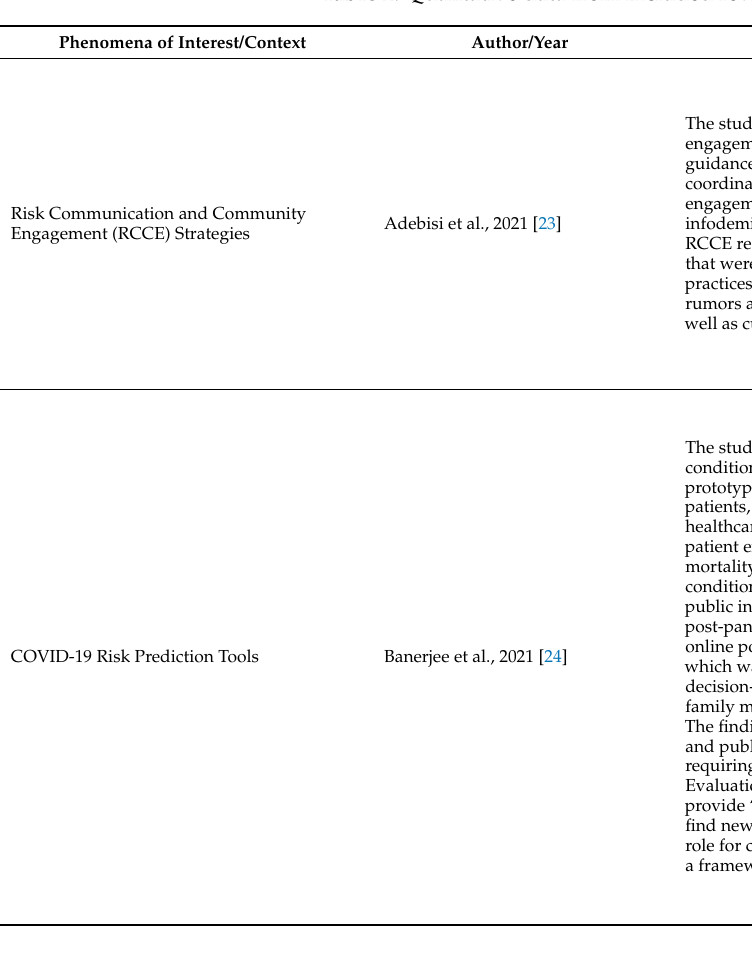
Table 2. Qualitative data from included review